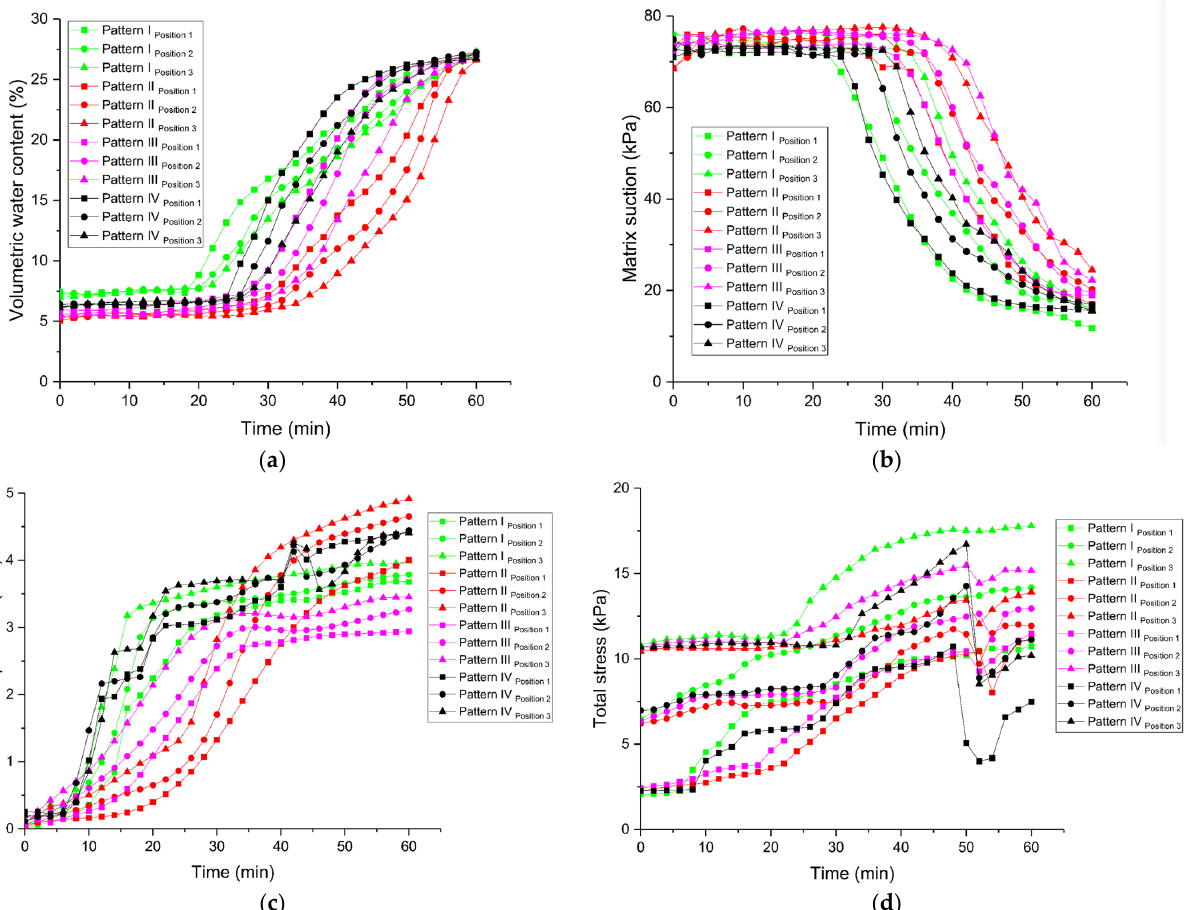
Figure 6. Variation in measured data when rainfall patterns are different: ( a ) water content; ( b ) matrix suction; ( c ) pore water pressure; ( d ) total stress.